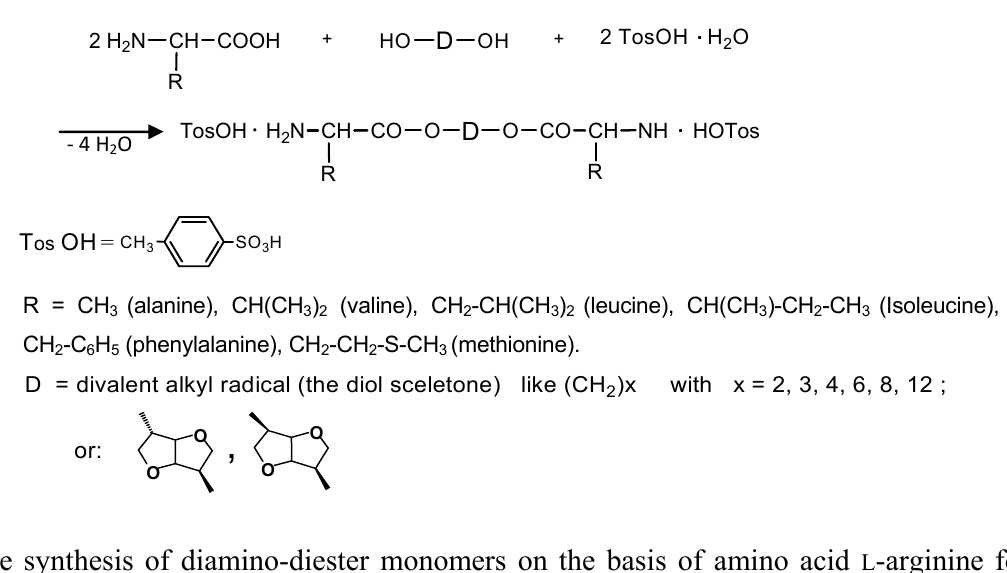
Figure 19. Synthesis of AAAD-S on the basis of hydrophobic